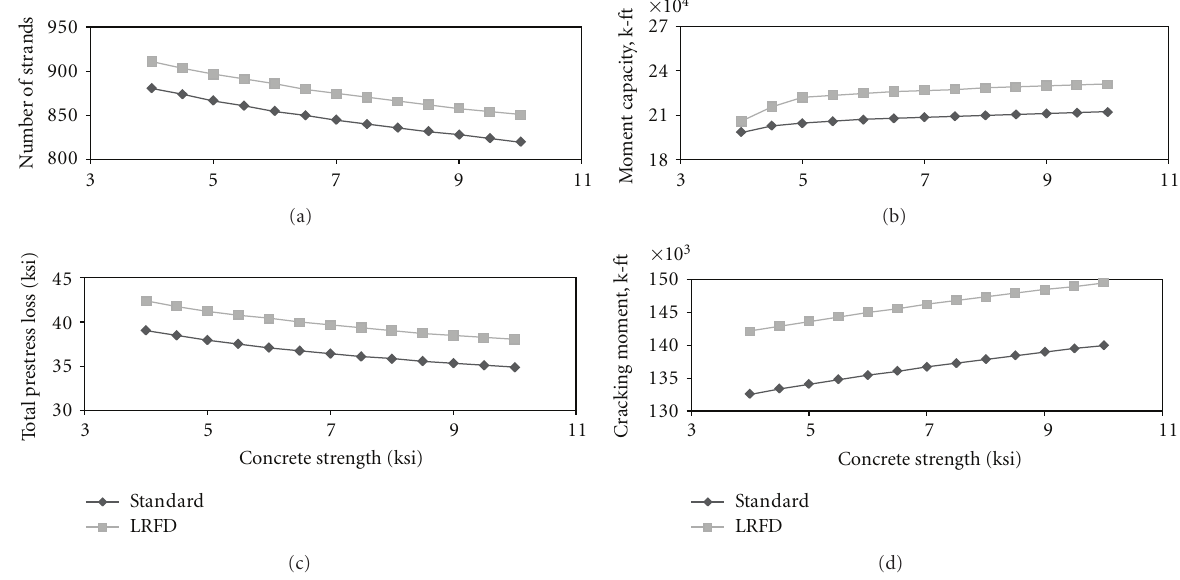
Figure 9: E ff ect of concrete strength for the span of 180 ft and 8 webs spaced at 10 ft: (a) on designed number of strands, (b) on moment capacity, (c) on final prestressing loss, and (d) on cracking